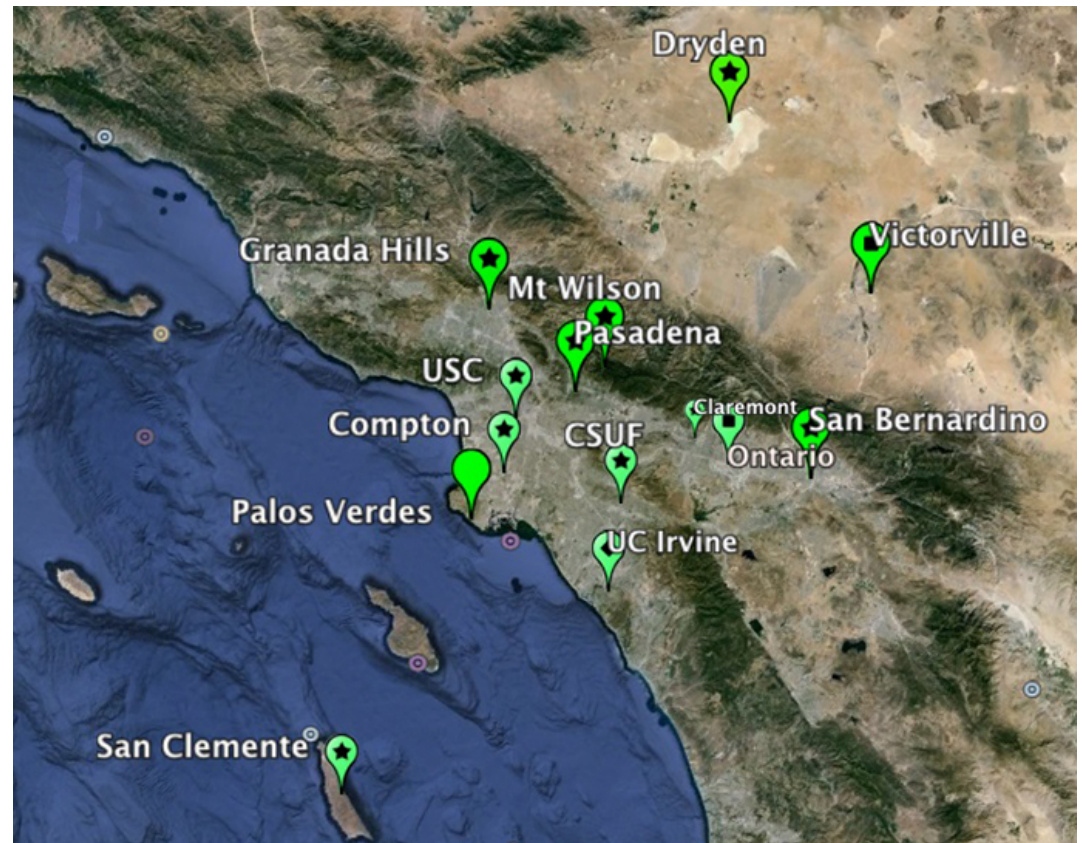
Figure A1. Google Earth map showing the location of the 14GHG measurement sites, only 13 of which are within the innermost model domain, the exception being the La Jolla